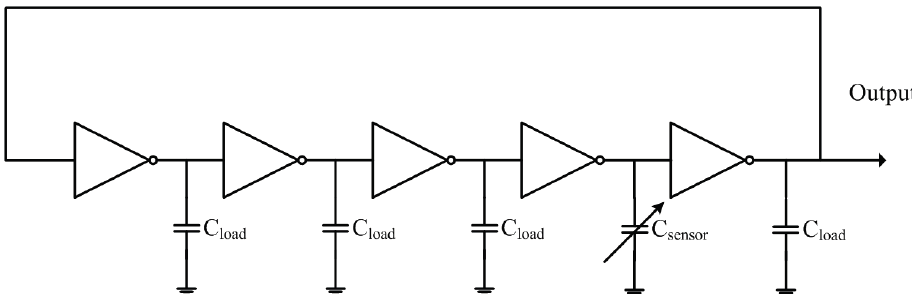
Figure 2. Ring oscillator circuit for the humidity sensor.